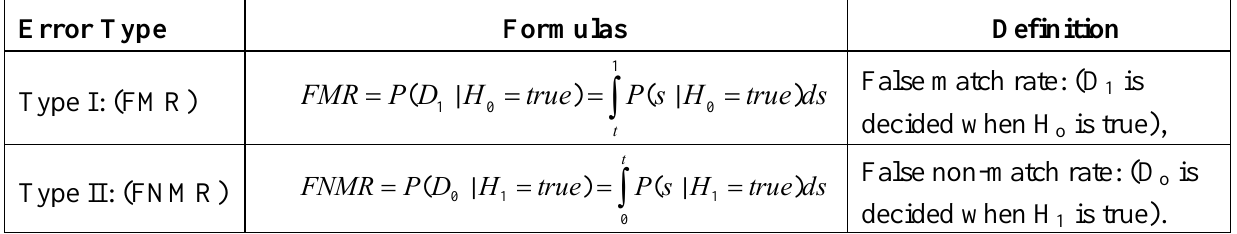
Table 3. Two types of errors in a typical biometric